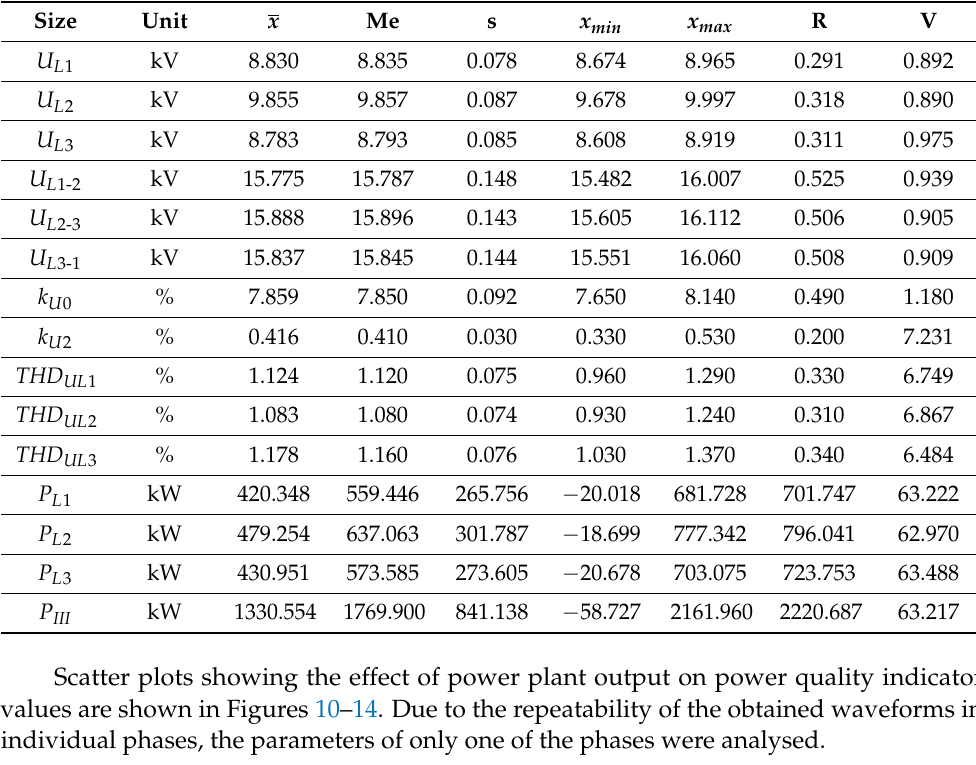
Scatterplot: P III vs. U L1 U L1 = 8.7233 + 0.80E-4 * P III Correlation: r = 0.85637